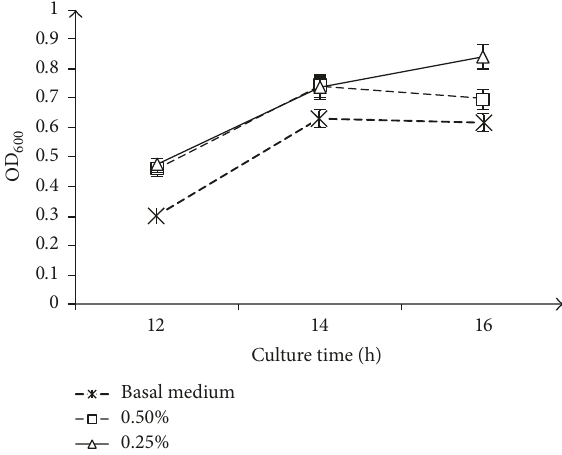
Figure 4: The influence of different concentrations of enzyme hydrolysis products of jujube polysaccharide on strain J-4 intestinal probiotics (bacterial growth determined by measuring OD 12h, 14h, and 16h into the culturing period). Values represent the mean of at least three biological replicates ± standard error of the